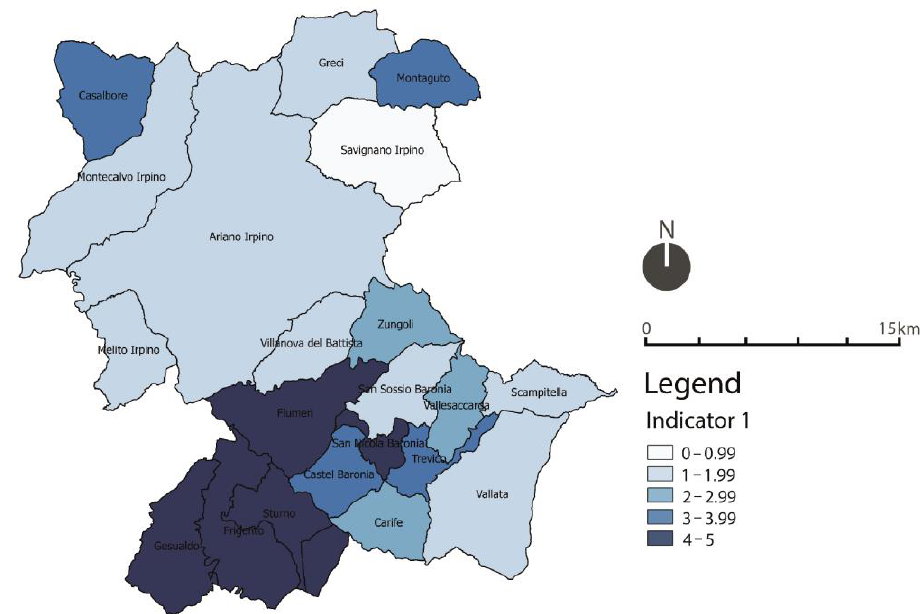
Figure 3. Map of indicator 1 “Degree of land infrastructure” © RI.P.R.O.VA.RE Project.